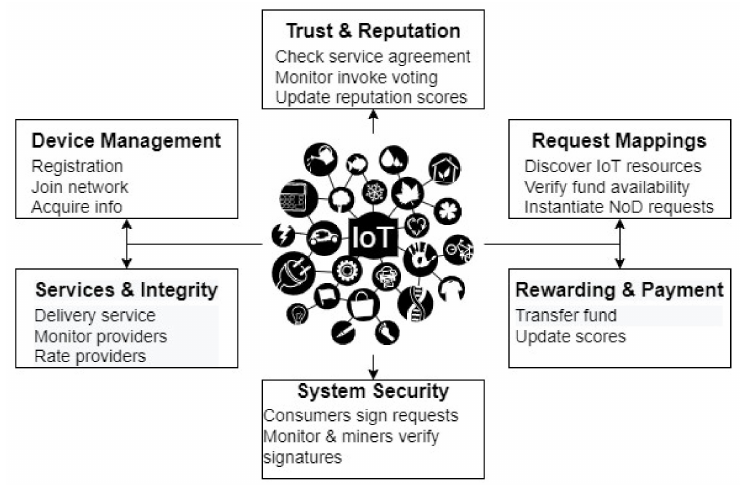
Figure 10. Resource share